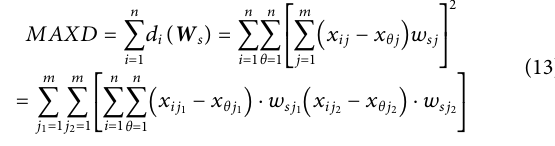
FIGURE 10 Comparison of the diameter of the grounding